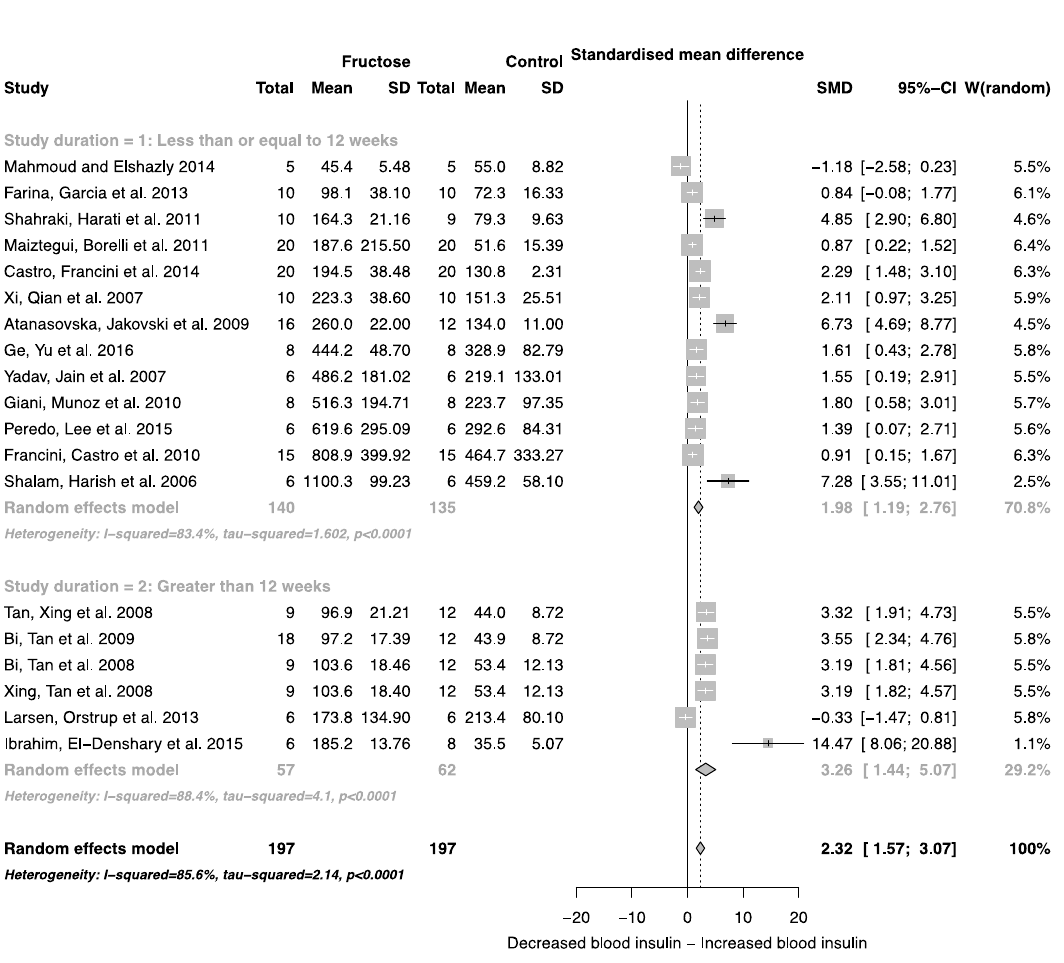
Figure 5. Forest plots of the effect of fructose consumption on adult male rodent blood insulin concentration (mean and standard deviation (SD)), split by study duration. The pooled effects estimates are represented by three diamonds; one for studies of 12 weeks or less, one for studies of greater than 12 weeks, and one representing the combined effect. Data are presented as standardized mean differences (SMD) with 95% confidence interval (CI). p ‐ Values are for the inverse variance random effects models with DerSimonian ‐ Laird estimator for Tau 2 . Inter ‐ study heterogeneity was tested by Cochran’s Q at a significance of p < 0.10 and quantified by I 2 .